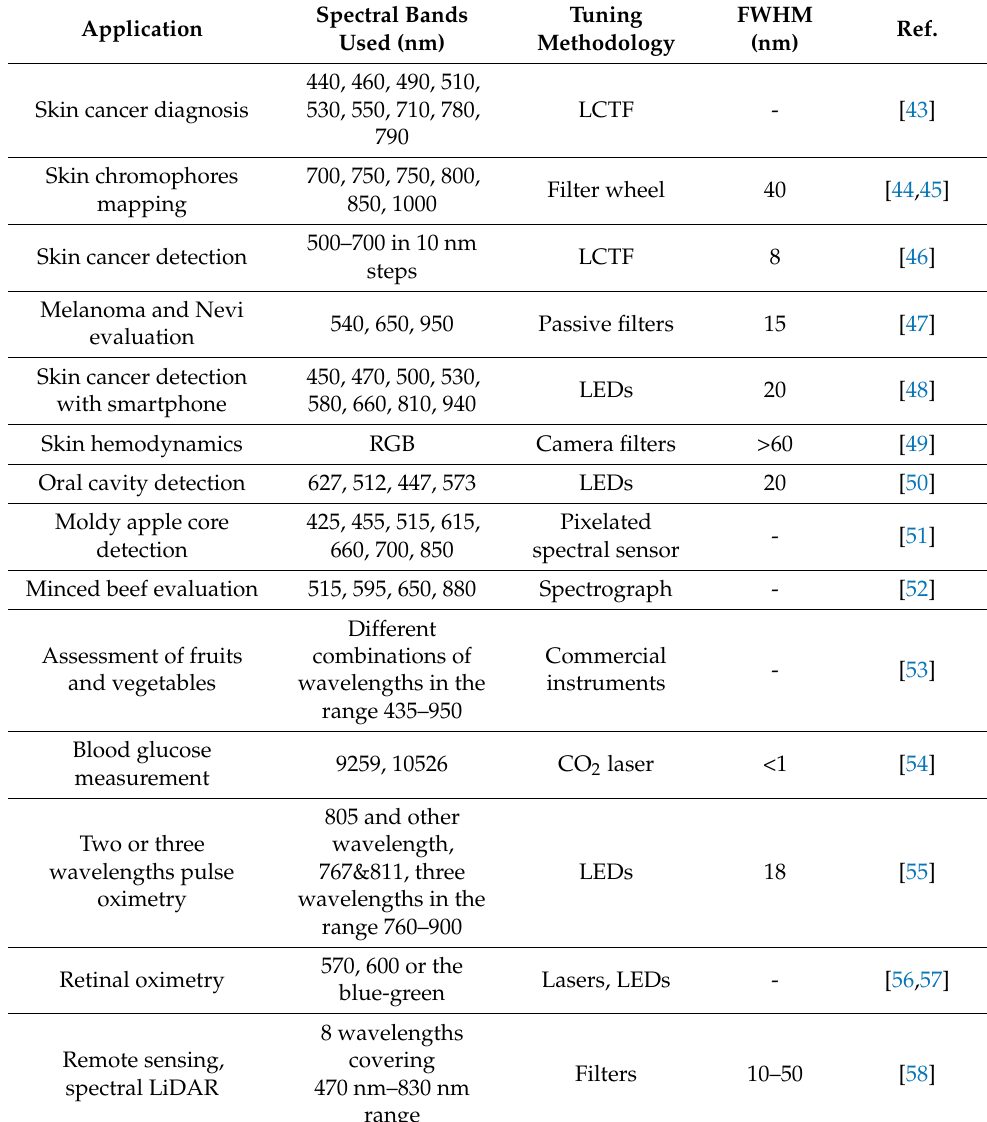
Table 1. Selection of applications from different fields that use only small number of